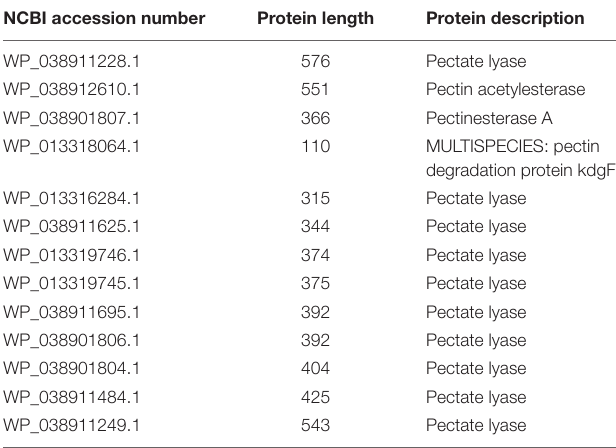
TABLE 4 | Pectin degradation related enzymes produced by Dickeya dadantii DSM 18020.